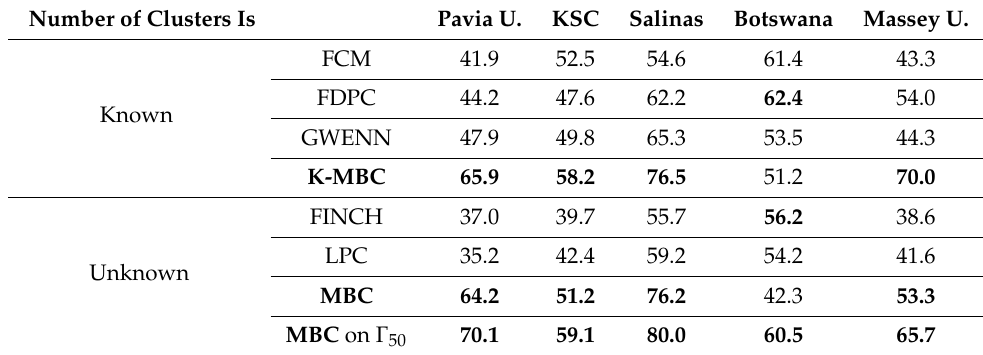
Table 4. Comparison of clustering results: Overall Accuracy (%). Number of Clusters Is